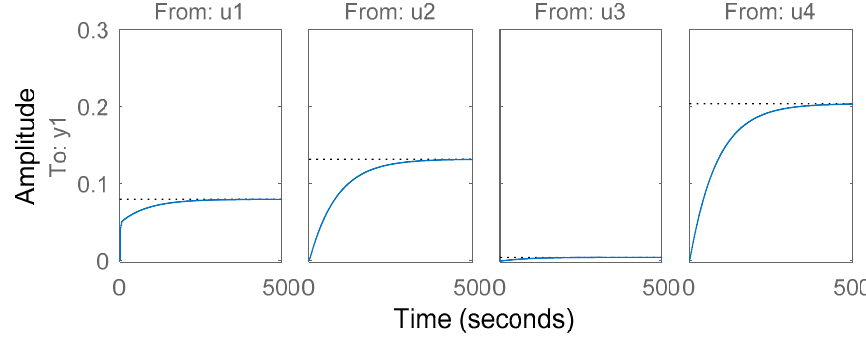
Figure 10. Step responses of the autoregressive model with exogenous inputs (ARX) model for burning rate prediction. u1: primary air; u2: secondary air; u3: stoker speed; and u4: fuel moisture content.